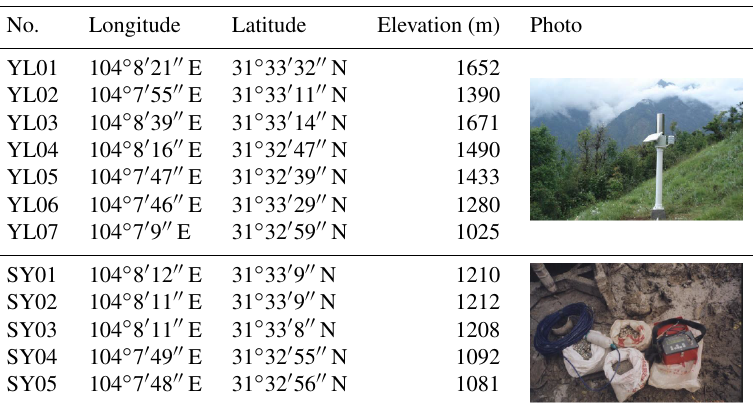
Figure 6. Layout map of the monitoring devices installed in the Wenjia gully (the base map is from Google Earth, the date of the background image is 18 December 2010). Table 2. List of monitoring devices in the Wenjia